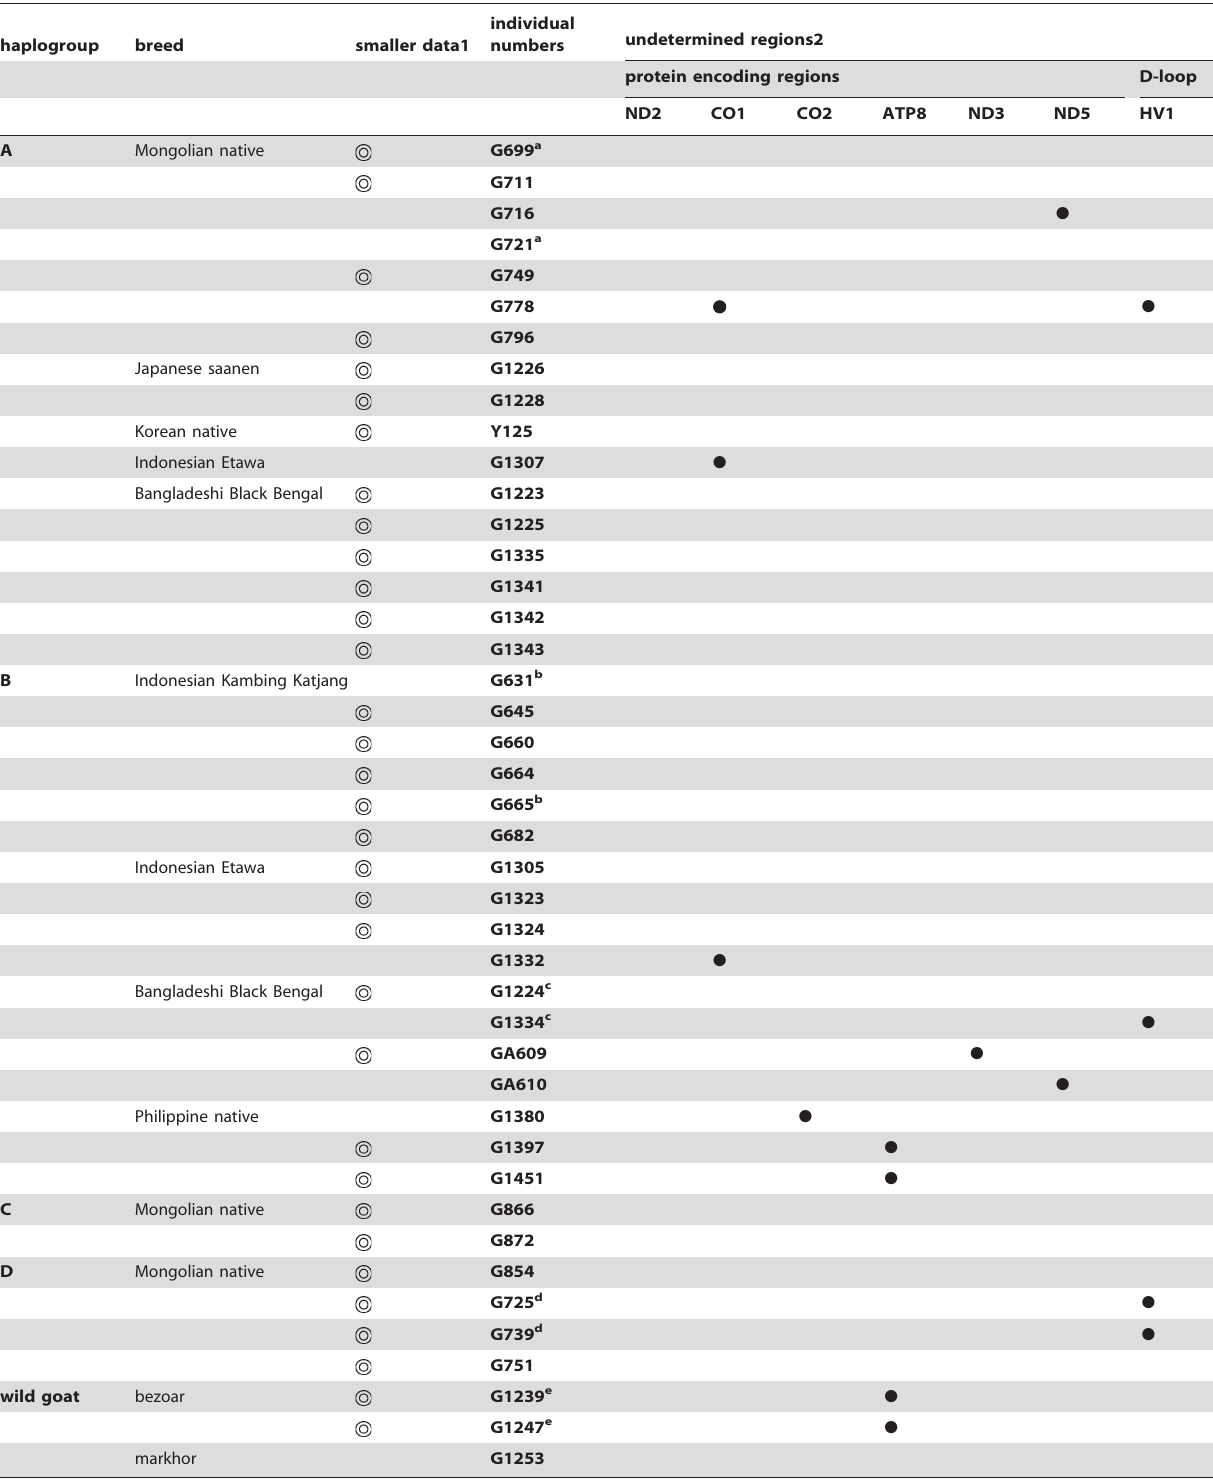
1 Samples that were used for the small data set indicated by . 2 Undetermined regions indicated by (cid:3) . a,b,c,d,e Identical haplotypes. The sequences downloaded from NCBI (GU068049: haplogroup A; GU295658: haplogroup B) were analyzed for both small and large data sets.